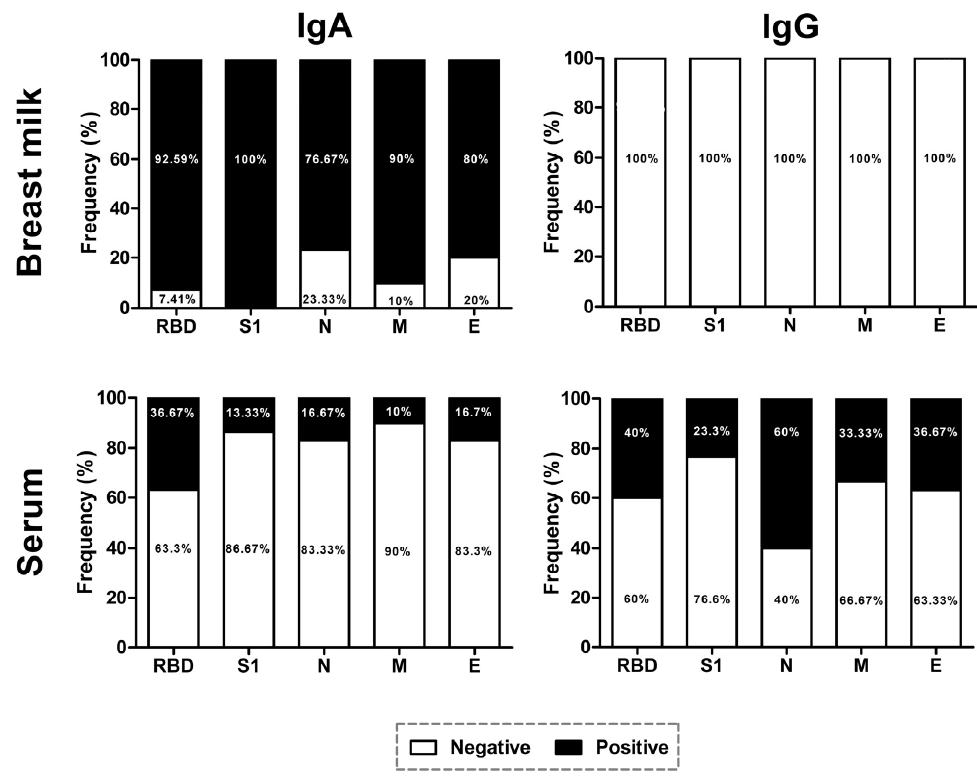
Figure 2. IgA and IgG seroprevalence against structural proteins of SARS-CoV-2 in breast milk and serum samples. Collected samples derived from breastfeeding women were tested against the recombinant RBD and S1 domain of the spike protein, nucleocapsid, membrane, and envelope of the SARS-CoV-2.